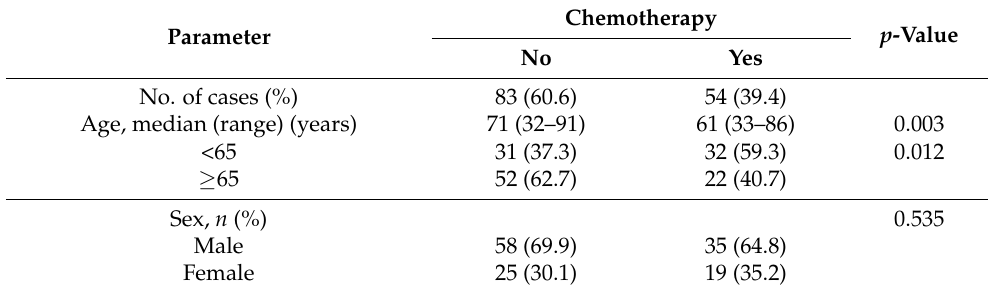
Table 1. Clinicopathological parameters of pathological T3N0M0 patients in terms of